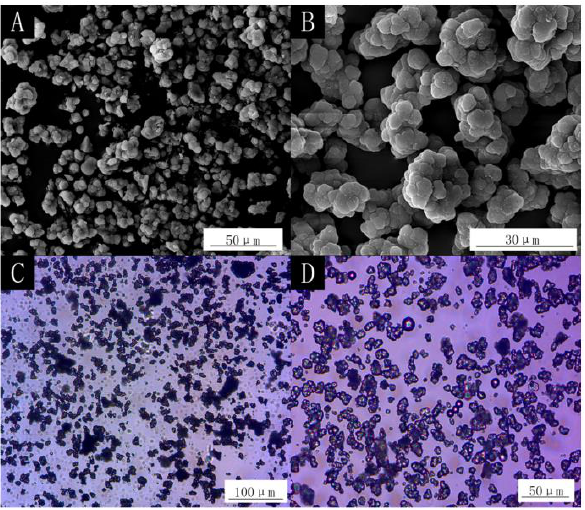
Figure 4. SEM and microscopic images of the microcapsules (the core–shell ratio is 0.67:1). SEM of ( A ) low magnification, and ( B ) high magnification, and optical microscopy images of ( C ) low magnification, and ( D ) high magnification.